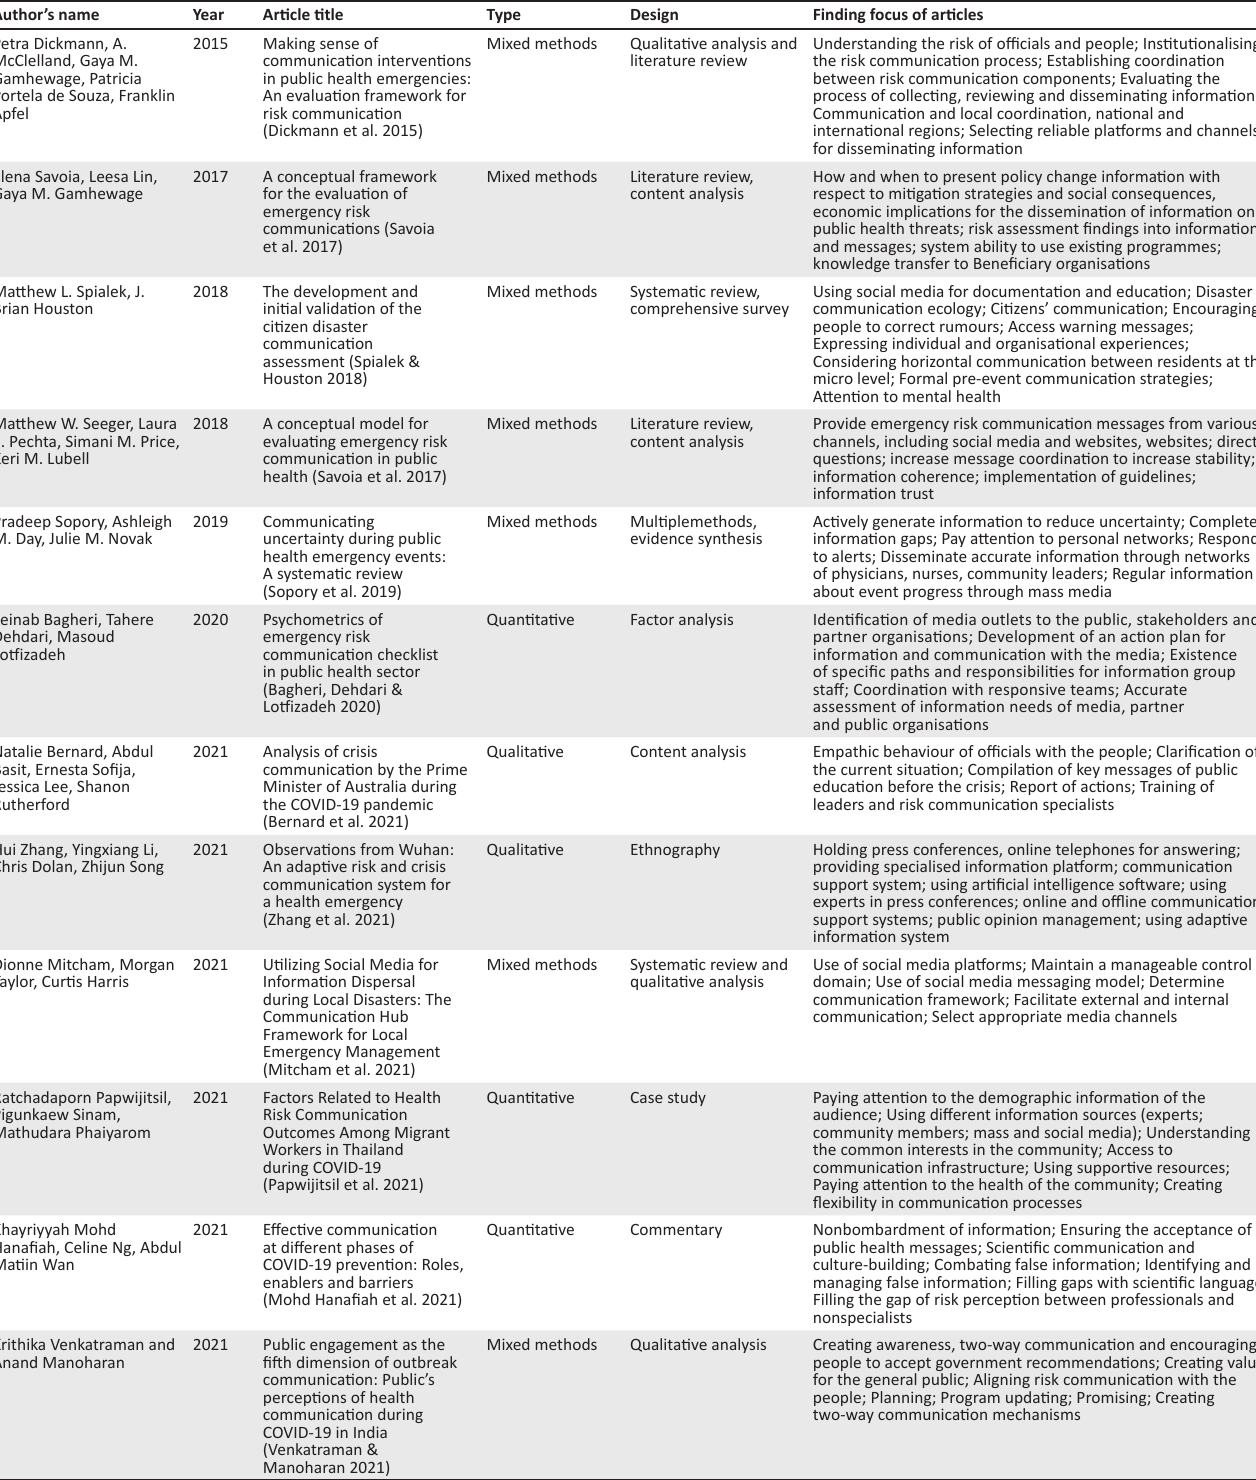
TABLE 3 (Continues...): Characteristics of the articles included in the systematic